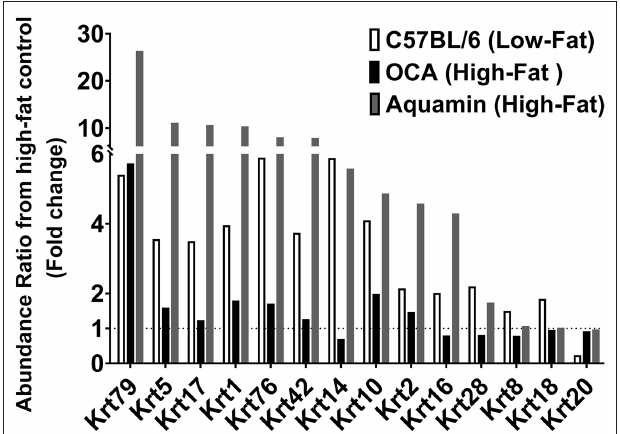
FIGURE 5 | Keratins upregulated in response to Aquamin ® . Values represent average fold-change from high-fat control based on n = 5 liver samples per treatment group. Corresponding values for response to a low-fat diet and response to OCA are shown for